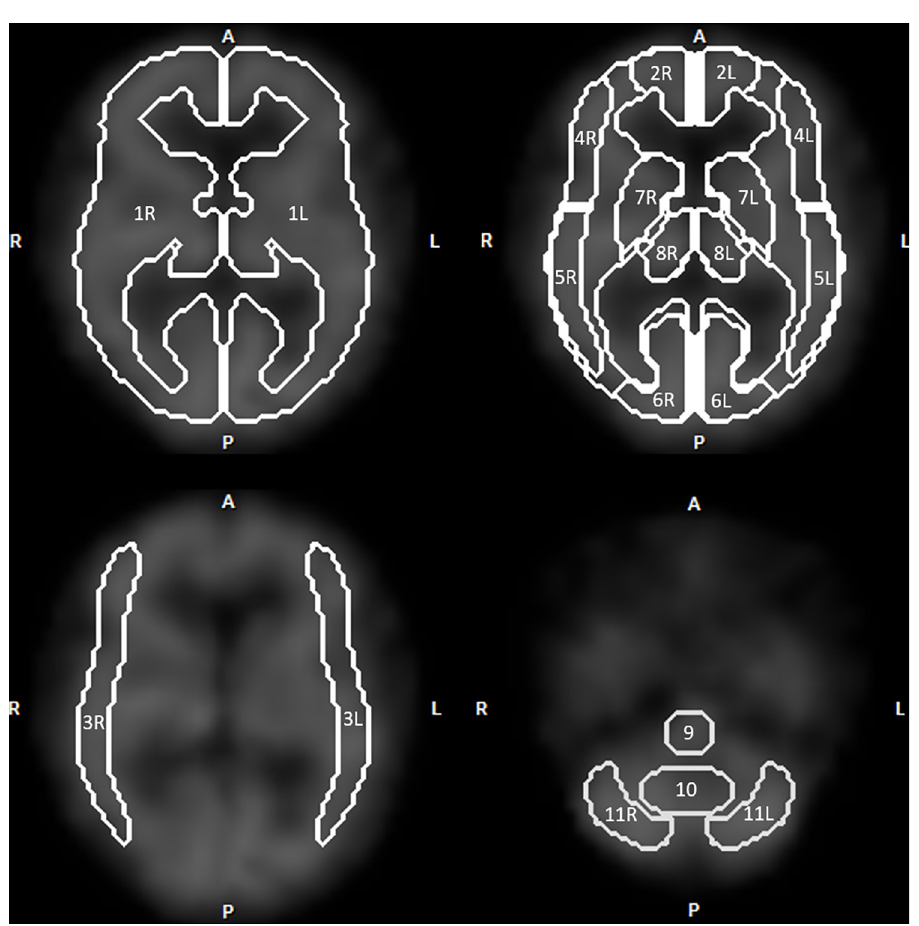
Fig 3. The regions of interest identified by the NEURO FLEXER software. Note. R, right; L, left; A, anterior; P, posterior; 1, hemisphere; 2, anterior cerebral artery; 3, middle cerebral artery (MCA); 4, anterior part of MCA; 5, posterior part of MCA; 6, posterior cerebral artery; 7, basal ganglia; 8, thalamus; 9, pons; 10, vermis; 11, cerebellum.